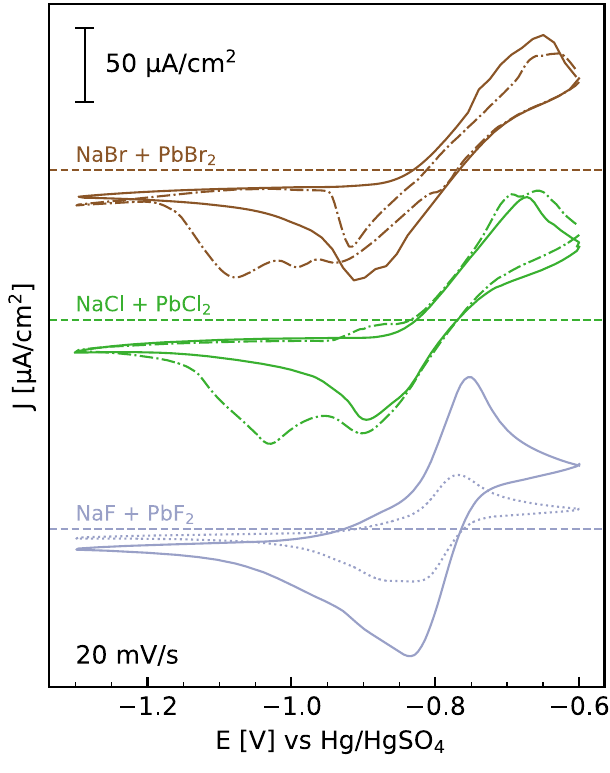
Fig. 1 | Electrochemical characterization of Pb halide deposition on Hg. Cyclic voltammograms of Hg in 0.01M NaBr+0.25mM PbBr 2 (brown), 0.01M NaCl+ 0.25mM PbCl 2 (green), 0.01M NaF+0.25mM PbF 2 , (blue solid line) and 0.01M NaF+0.12mM PbF 2 (blue dotted line). The CVs (offset for clarity, with current density j =0indicatedbydashedhorizontallines)weremeasuredat20mV/s.Solid linescorrespondtoCVsmeasureddirectlyafterimmersionoftheelectrodeintoPb- containing solution,whicharestablewithtime.Dotteddashed linescorrespondto the fi rst CV measured after keeping the potential for periods between 60 and 120min at potentials positive of − 0.8V (120min at − 0.60V, 60min at − 0.60V, for Br- and Cl-containing electrolytes,